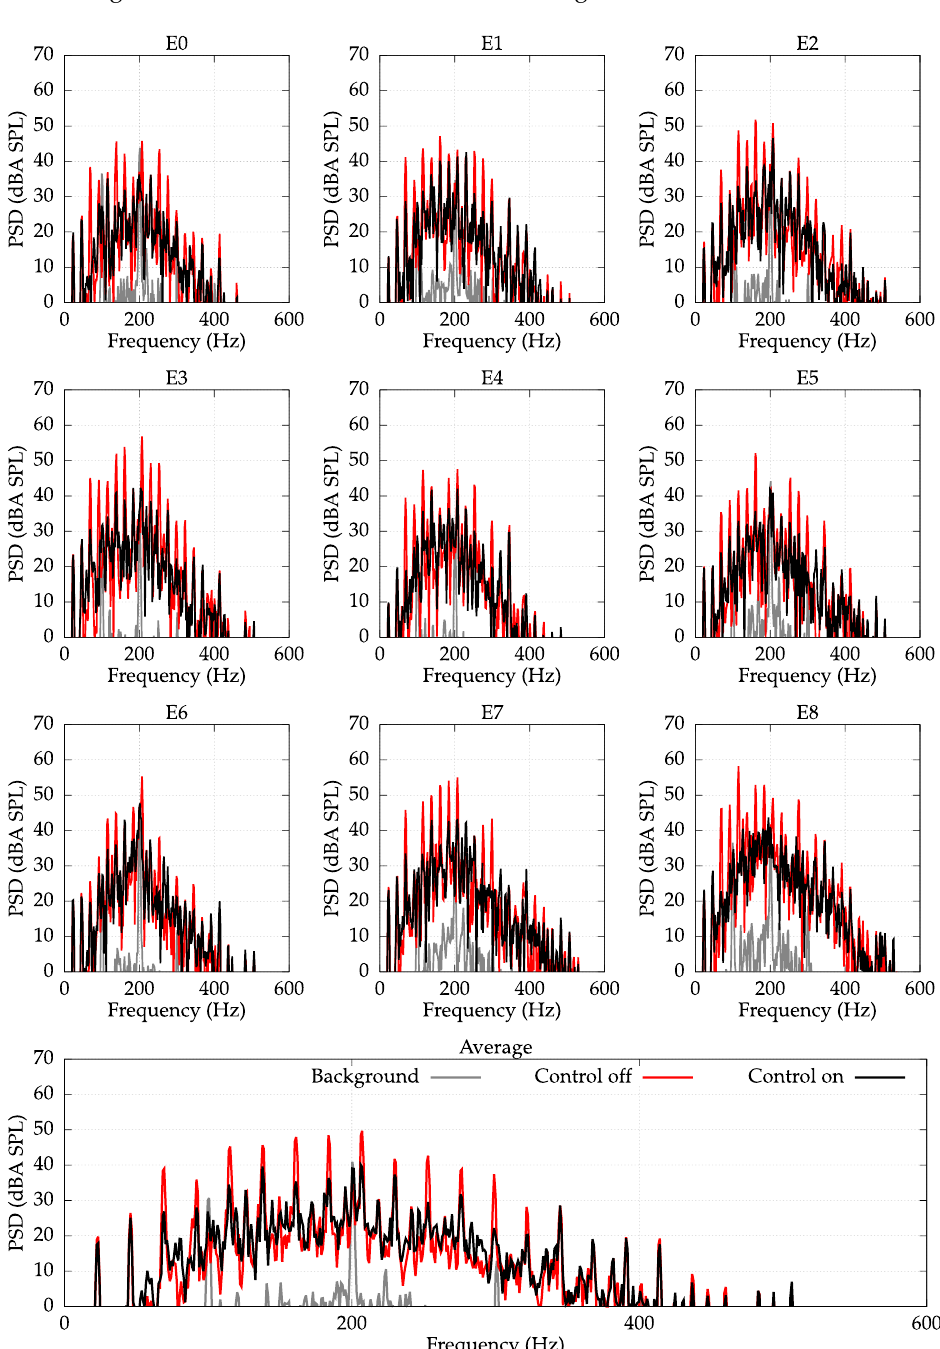
Figure 8. PSD with an A-weighting measured at error microphones E0–E8. Unbalanced load of 500 g. Spin velocity of 1340 RPM. The signals are filtered with a lowpass filter of cutoff frequency f c = 300 Hz. Average reduction: 16